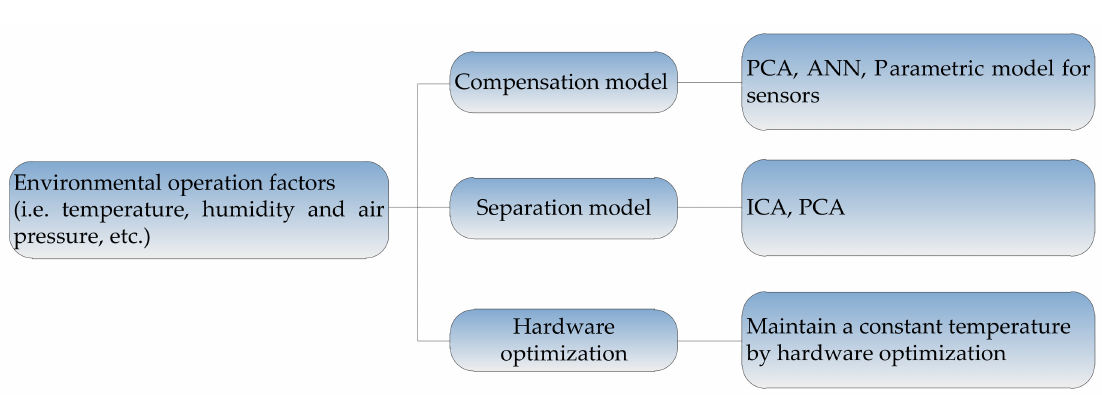
Figure 3. Methods for suppressing the interferences caused by environment